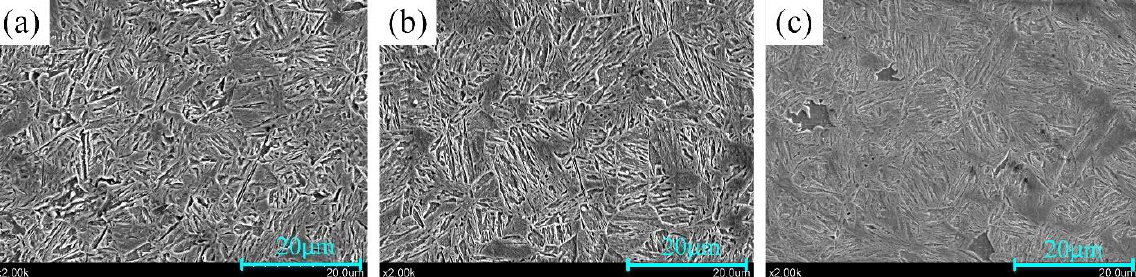
Figure 12. The substrate microstructure of samples at T 7 : ( a ) GA coated sample; ( b ) GI coated sample; ( c ) Al–Si coated sample.